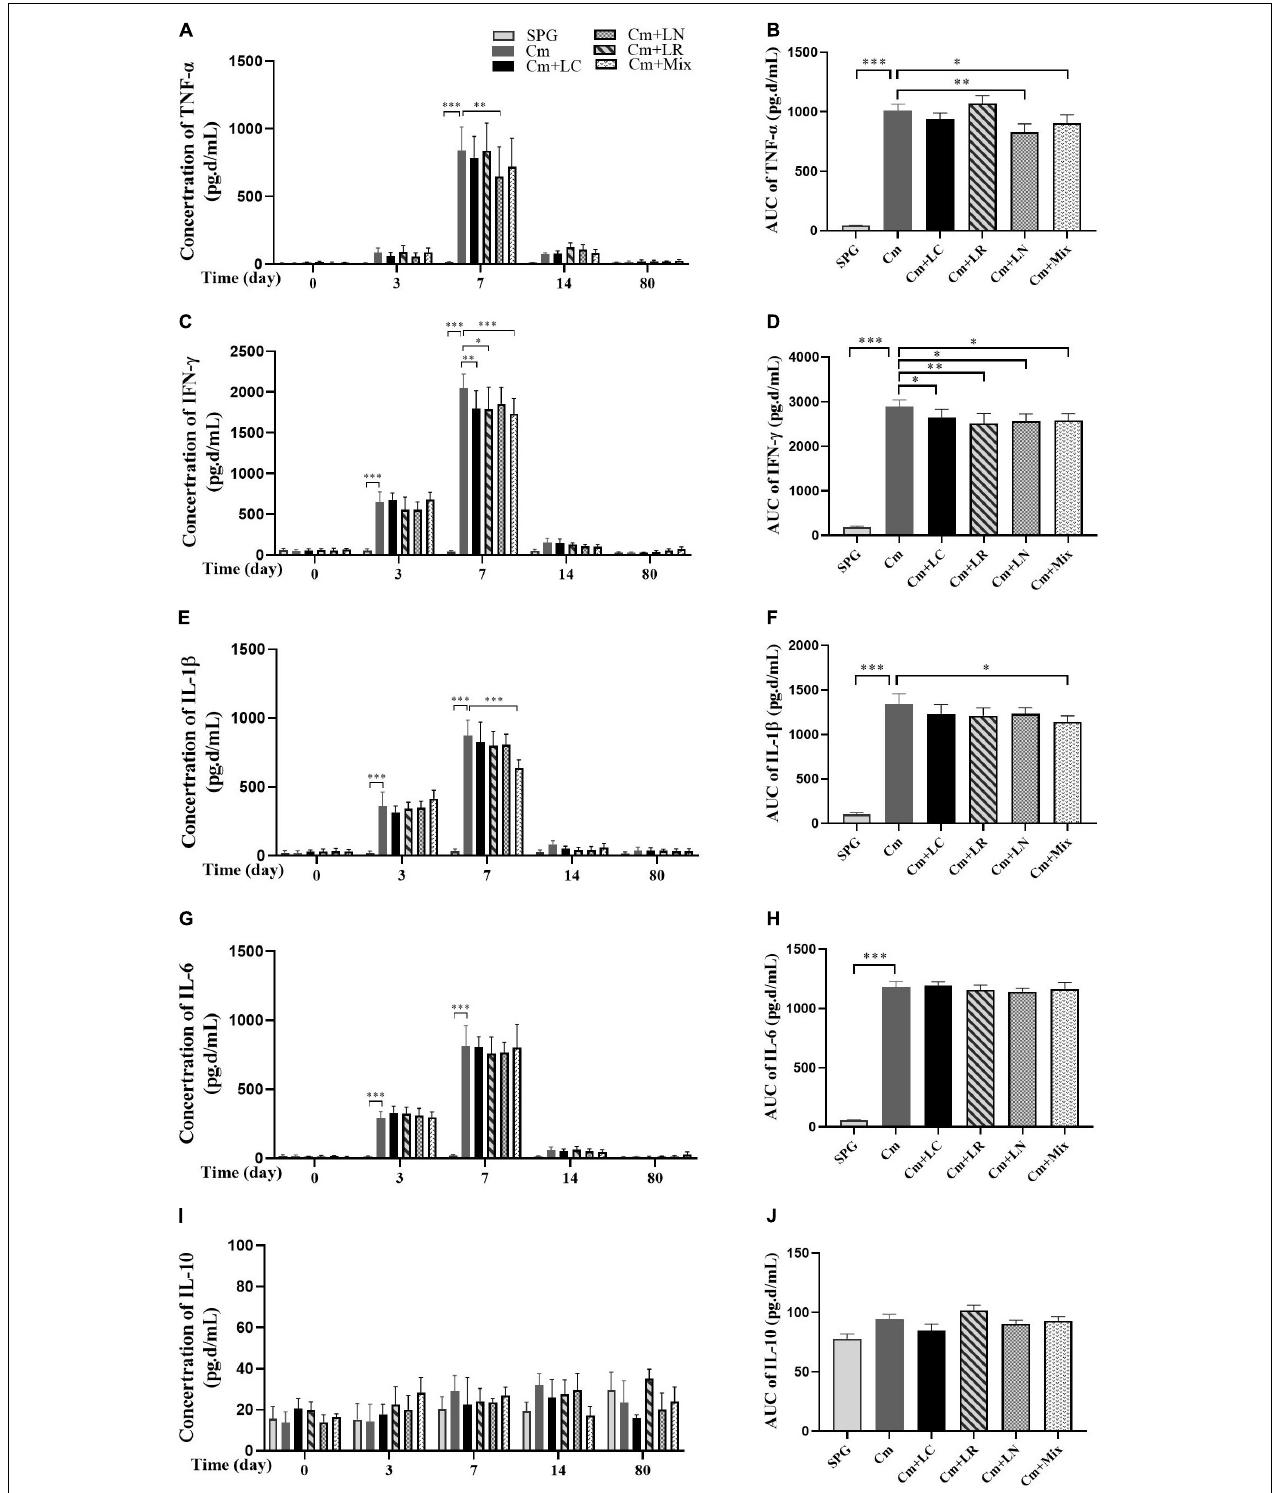
FIGURE 4 | Monitoring early cytokine production kinetics from mouse genital tract after genital chlamydia infection. Vaginal swabs were taken at different time points postinoculation (Days 0, 3, 7, 14, and 80) as indicated along the x -axis. The levels of TNF- α (A) , IFN- γ (C) , IL-1 β (E) , IL-6 (G) , and IL-10 (I) in the genital tract of mice were measured and expressed as pg/ml along the y -axis, with the corresponding area under the curve of which calculated on the right side (B,D,F,H,J) . Results from an independent sample. ∗ p < 0.05, ∗∗ p < 0.01, and ∗∗∗ p < 0.001 vs. the Cm group (one-way ANOVA).